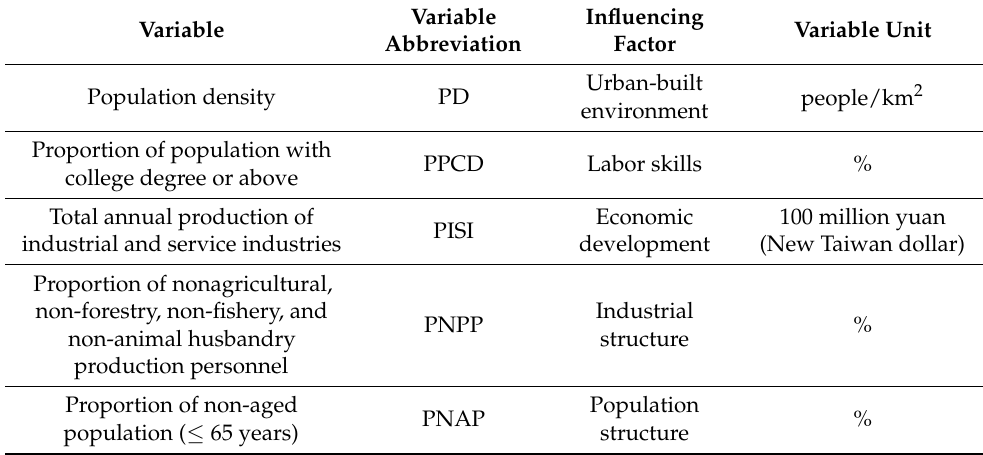
Table 6. Variables, variable abbreviations, influencing factors, and variable units in cluster